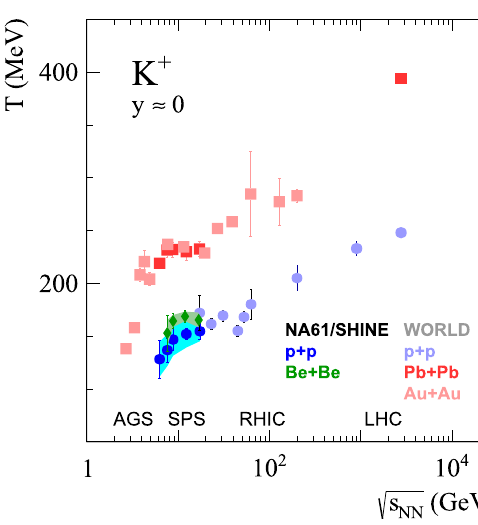
inelastic p+p interactions. Both statistical (vertical bars) and systematic uncertainties (shaded bands) are shown